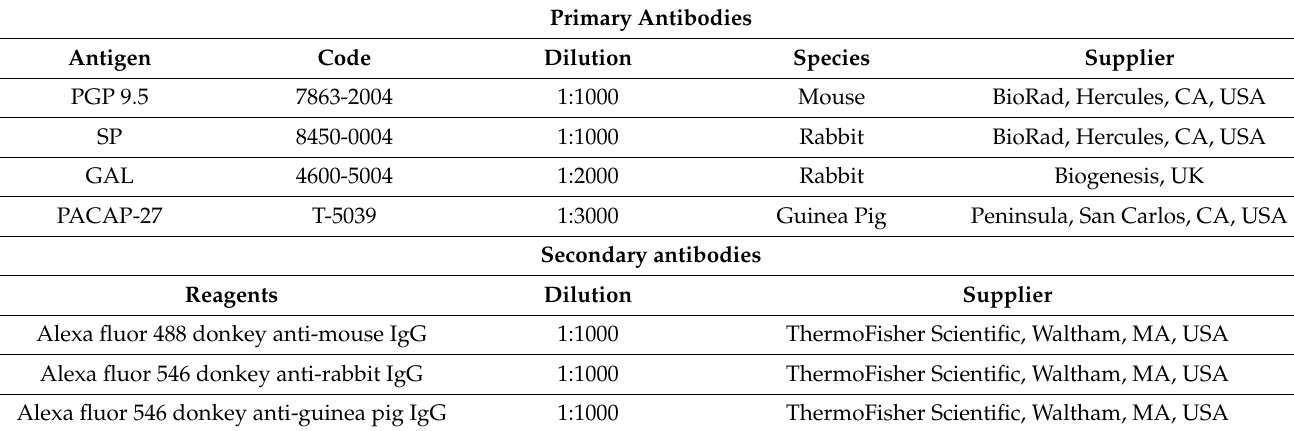
Table 1. Reagents used in immunofluorescence